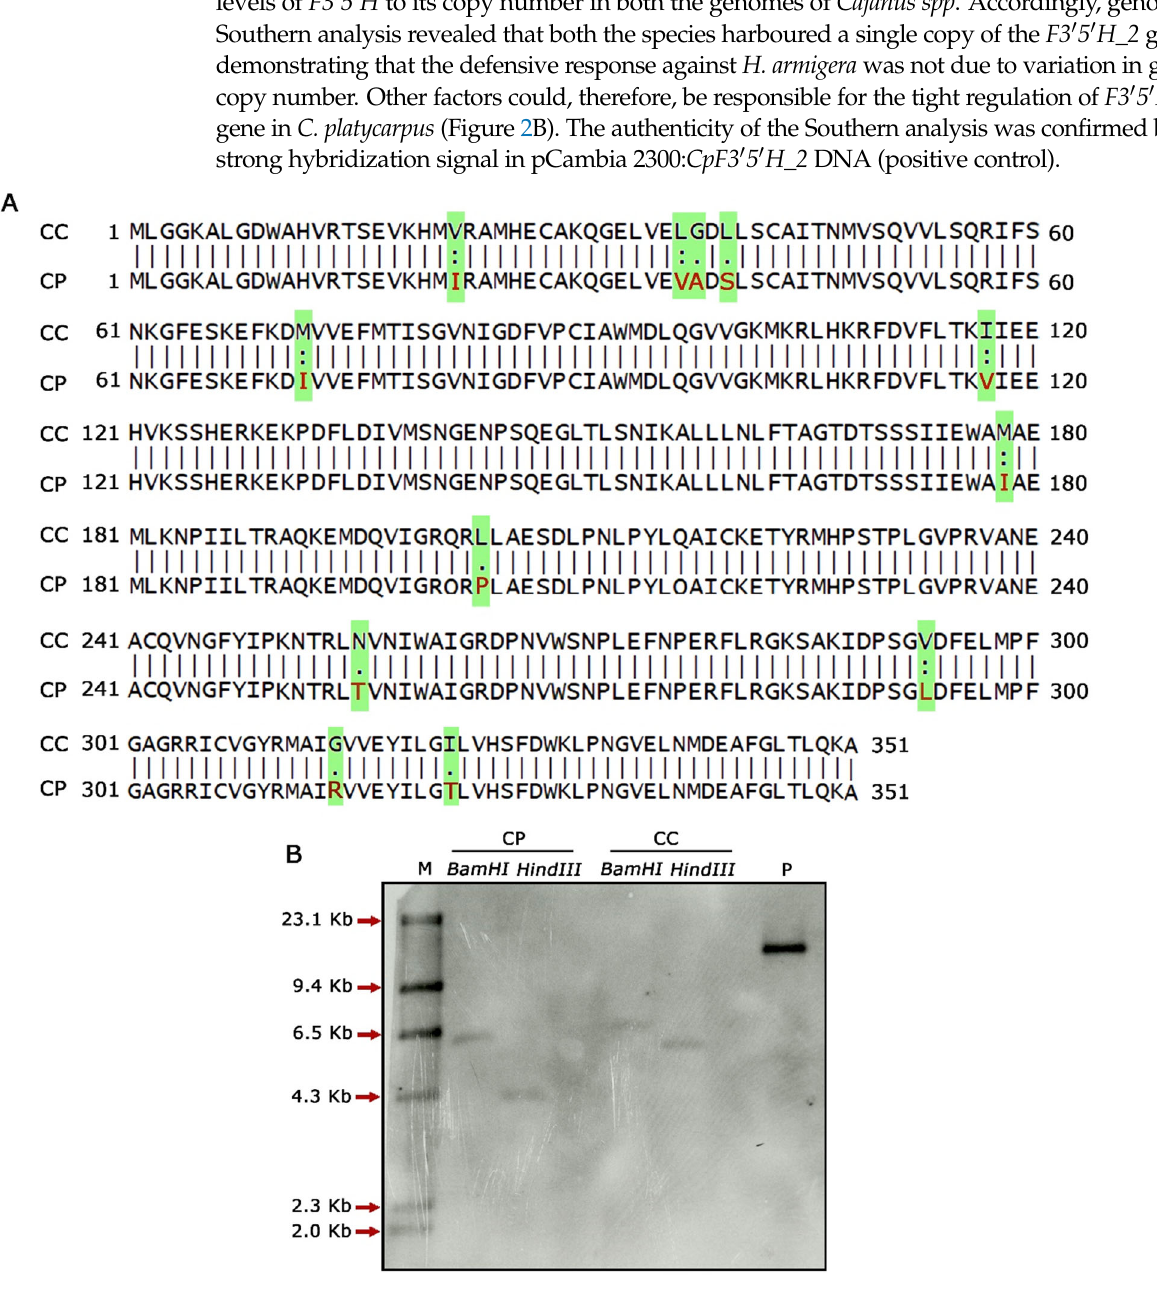
Figure 2. Molecular characterisation of F3 ′ 5 ′ H_2 gene in C. cajan and C. platycarpus . ( A ) Pairwise alignment of amino acid sequences between F3 ′ 5 ′ H_2 of C. cajan and C. platycarpus . Highlighted text indicates variation in amino acid sequences between the two Cajanus species. ( B ) Genomic Southern analysis of F3 ′ 5 ′ H_2 depicting gene copy number in both the Cajanus spp. CP, Cajanus platycarpus ; CC, Cajanus cajan ; M, Dig labelled marker; P, positive control ‐ pCambia 2300 harbouring CpF3 ′ 5 ′ H_2 gene.